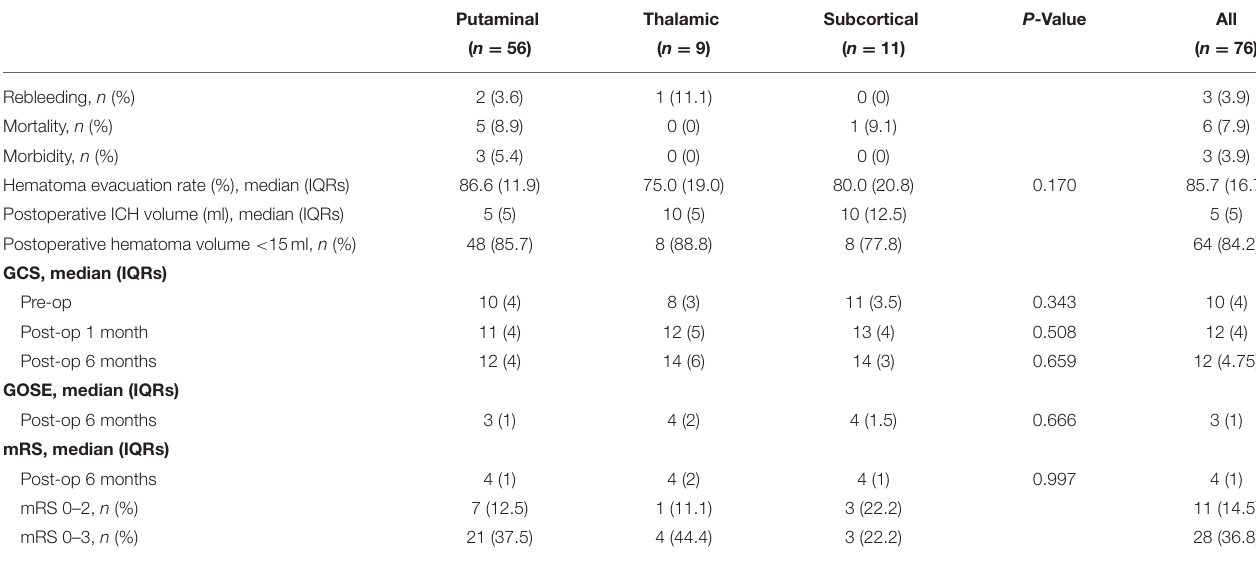
TABLE 2 | Outcomes.